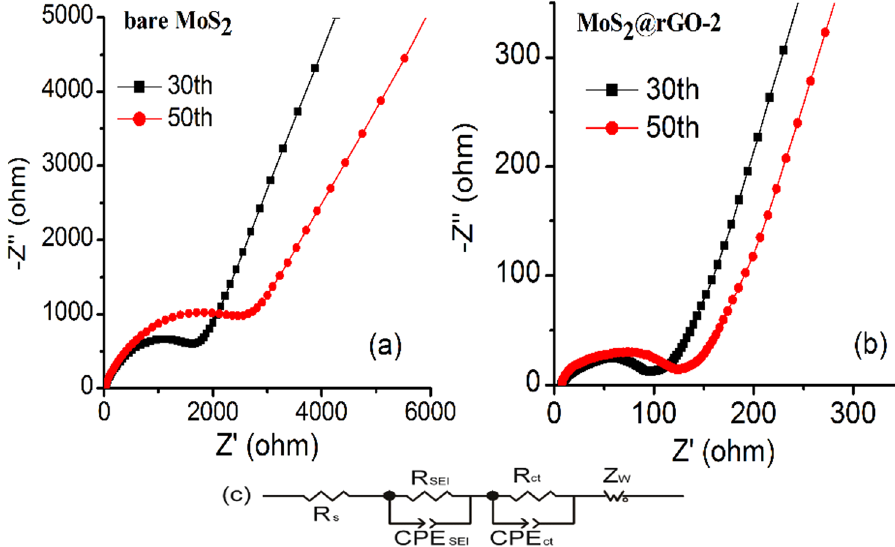
Figure 7. The nyquist plots of the ( a ) pristine MoS 2 , ( b ) MoS 2 @rGO-2, and ( c ) the equivalent circuit for EIS fitting.